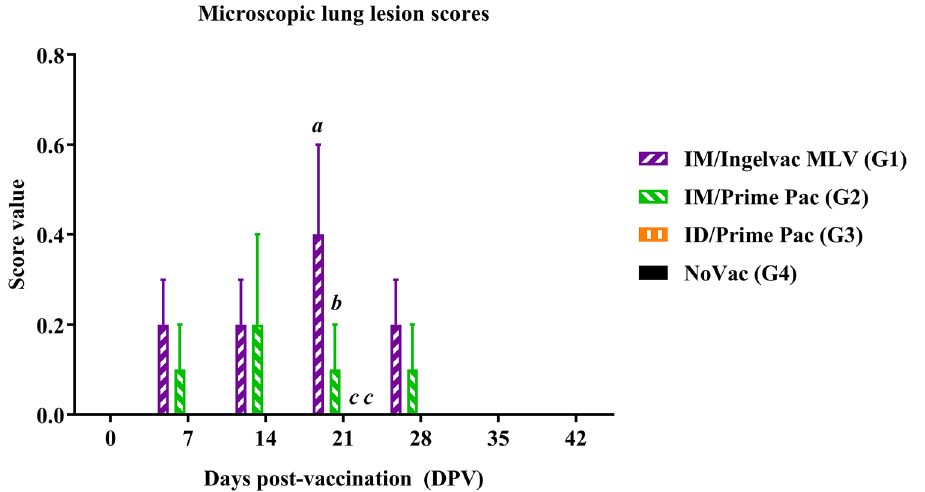
Figure 5. The mean values of the microscopic lung lesion scores of pigs in Exp A following vaccination. Values expressed as mean ± SEM. The results were compared using two-way ANOVA for multiple comparisons. Different lowercase letters ( a – c ) indicate significant differences between treatment groups ( P < 0.05) for each